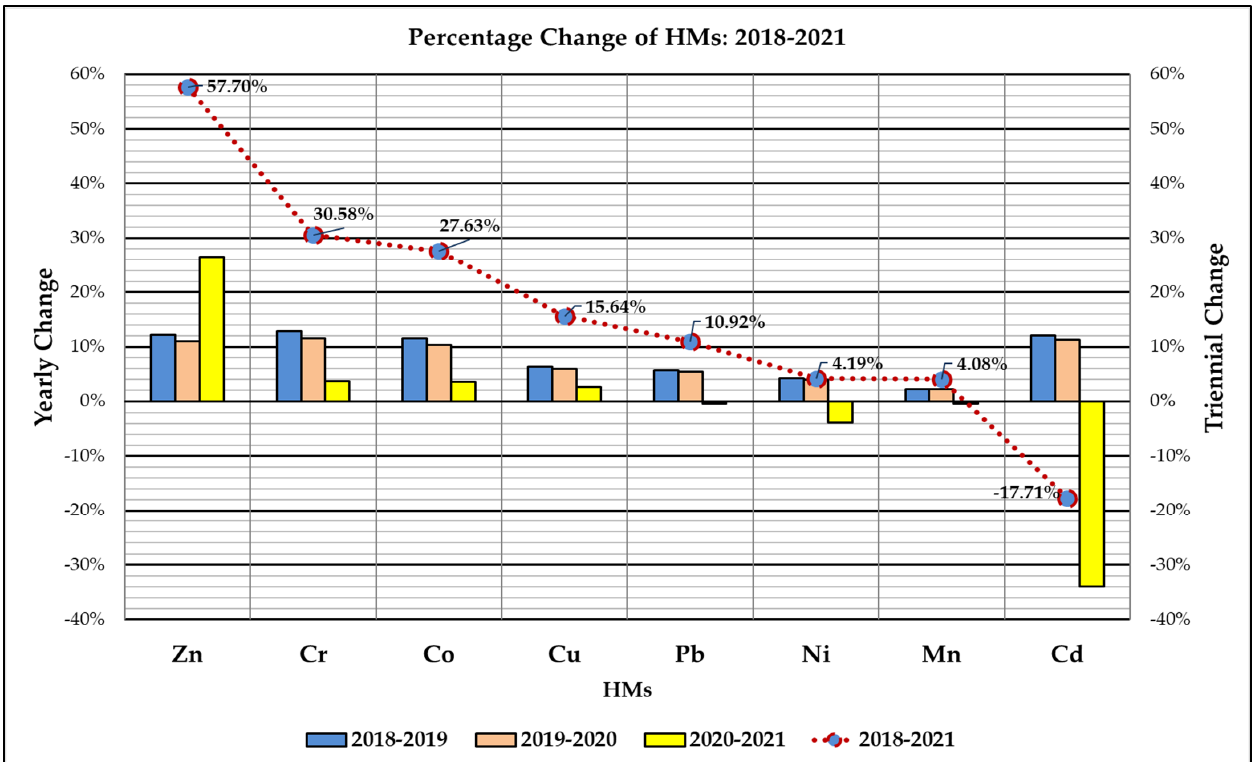
Figure 1. Yearly and triennial percentage change in the total concentrations of HMs from 2018 to 2021.